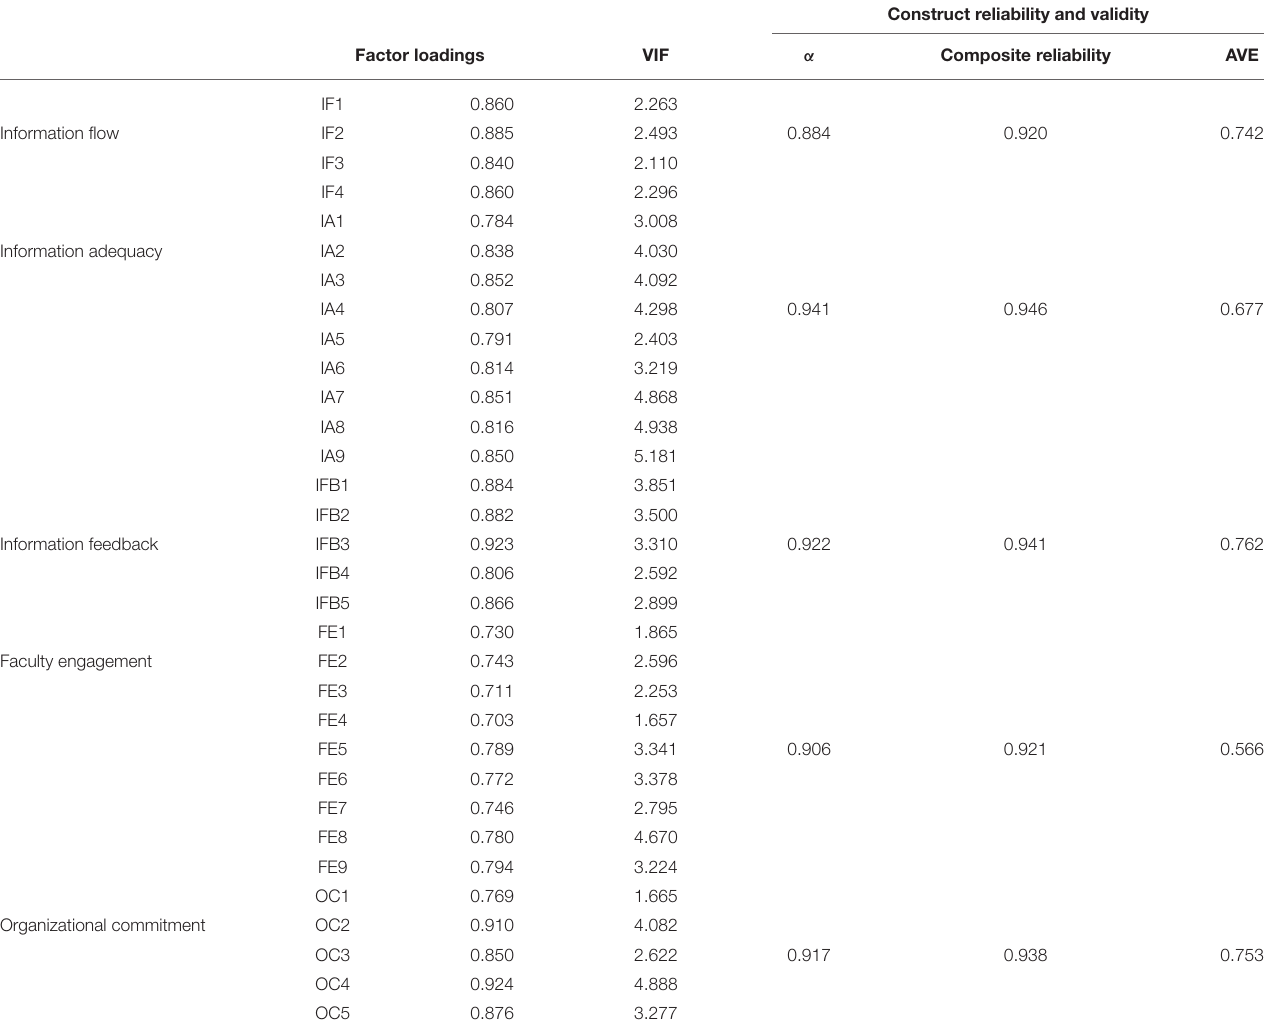
TABLE 2 | Model assessment (direct